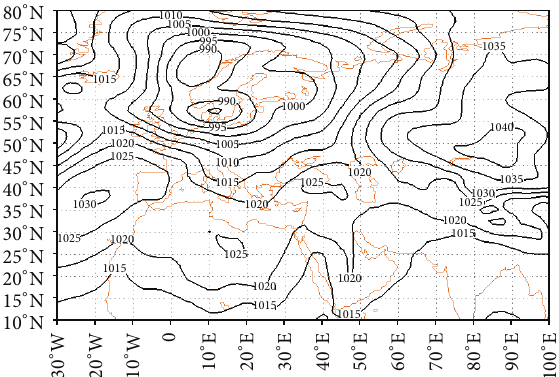
Figure 7: Sea level pressure map.